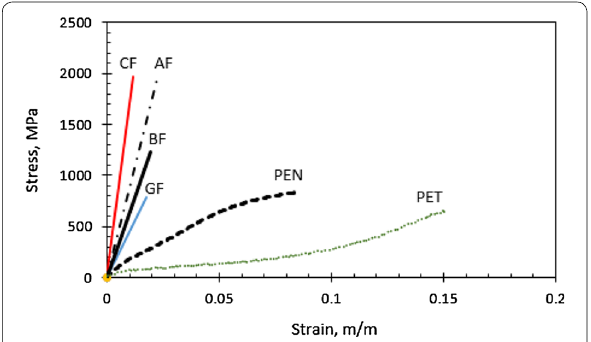
Fig. 1 Stress-strain relationship of various